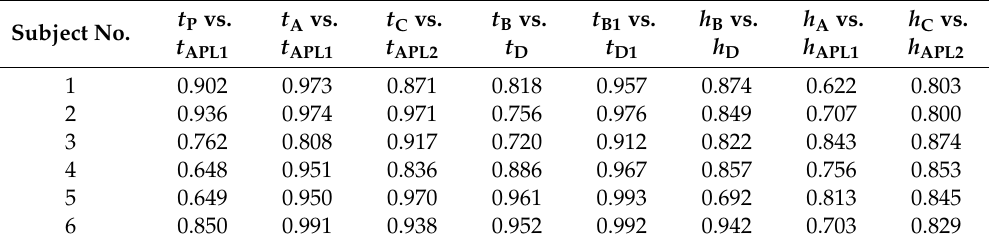
Table 1. Pearson correlation coe ffi cients for di ff erent dependencies for all